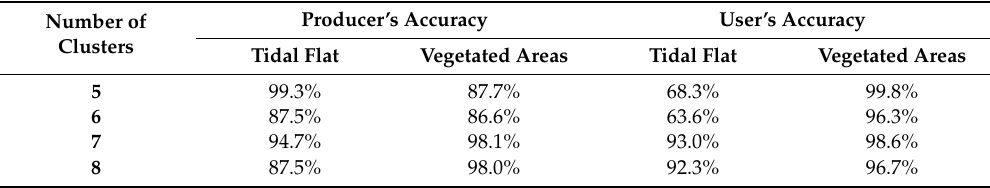
Table 7. Summary of the quantitative assessment of UAS-SfM segmentation results for tidal flat and vegetated areas when increasing the number of